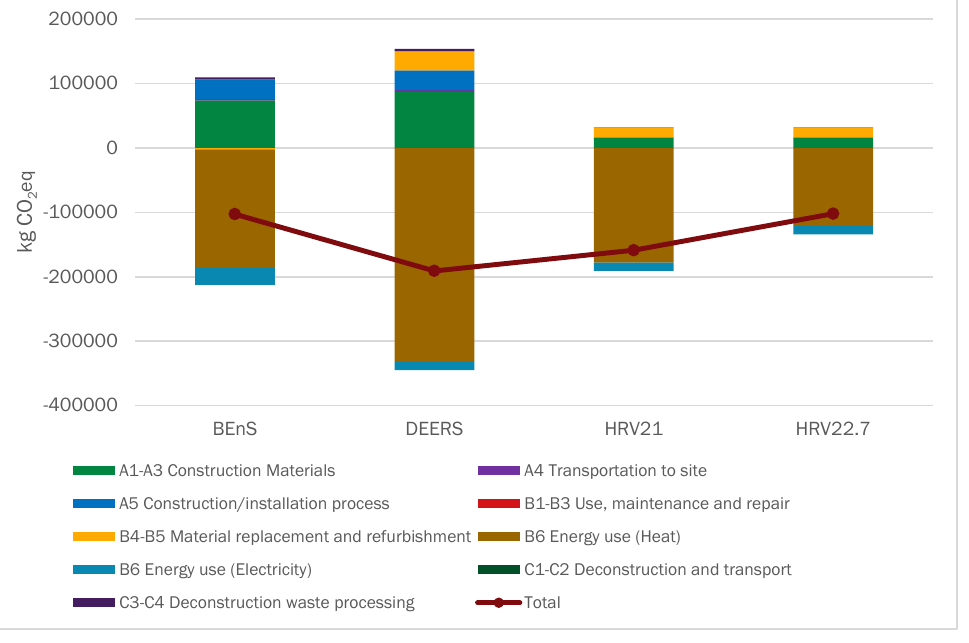
Figure 2. Global warming potential (CO 2 eq). Energies 2019 , 12 , 344